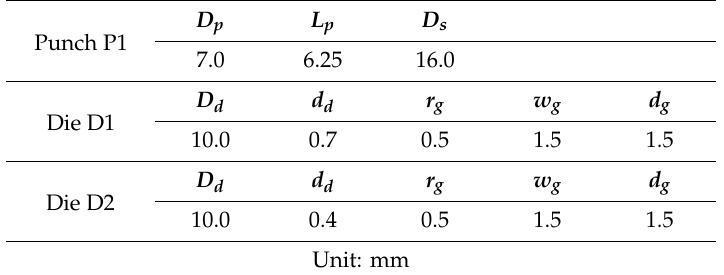
Table 2. Detailed dimensions of a circular punch and two circular dies.